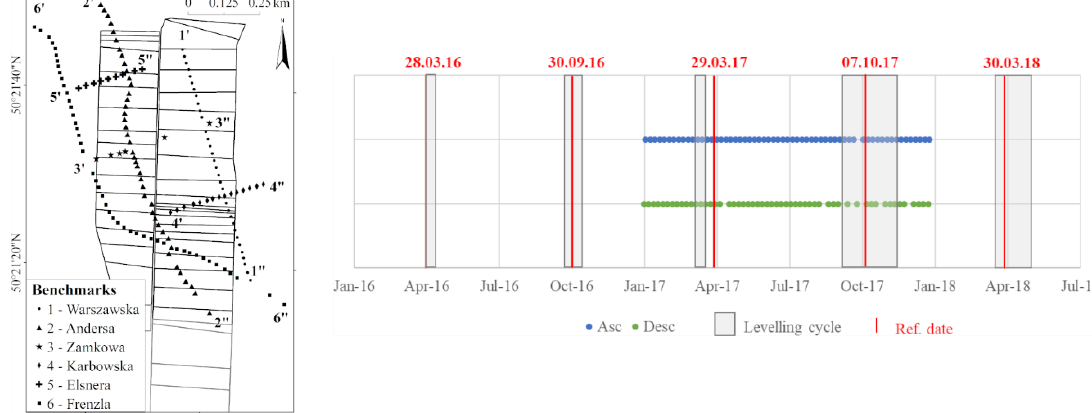
Figure 7. Levelling network in the Miechowice district ( left ) and the chosen reference dates for each levelling cycle ( right ).